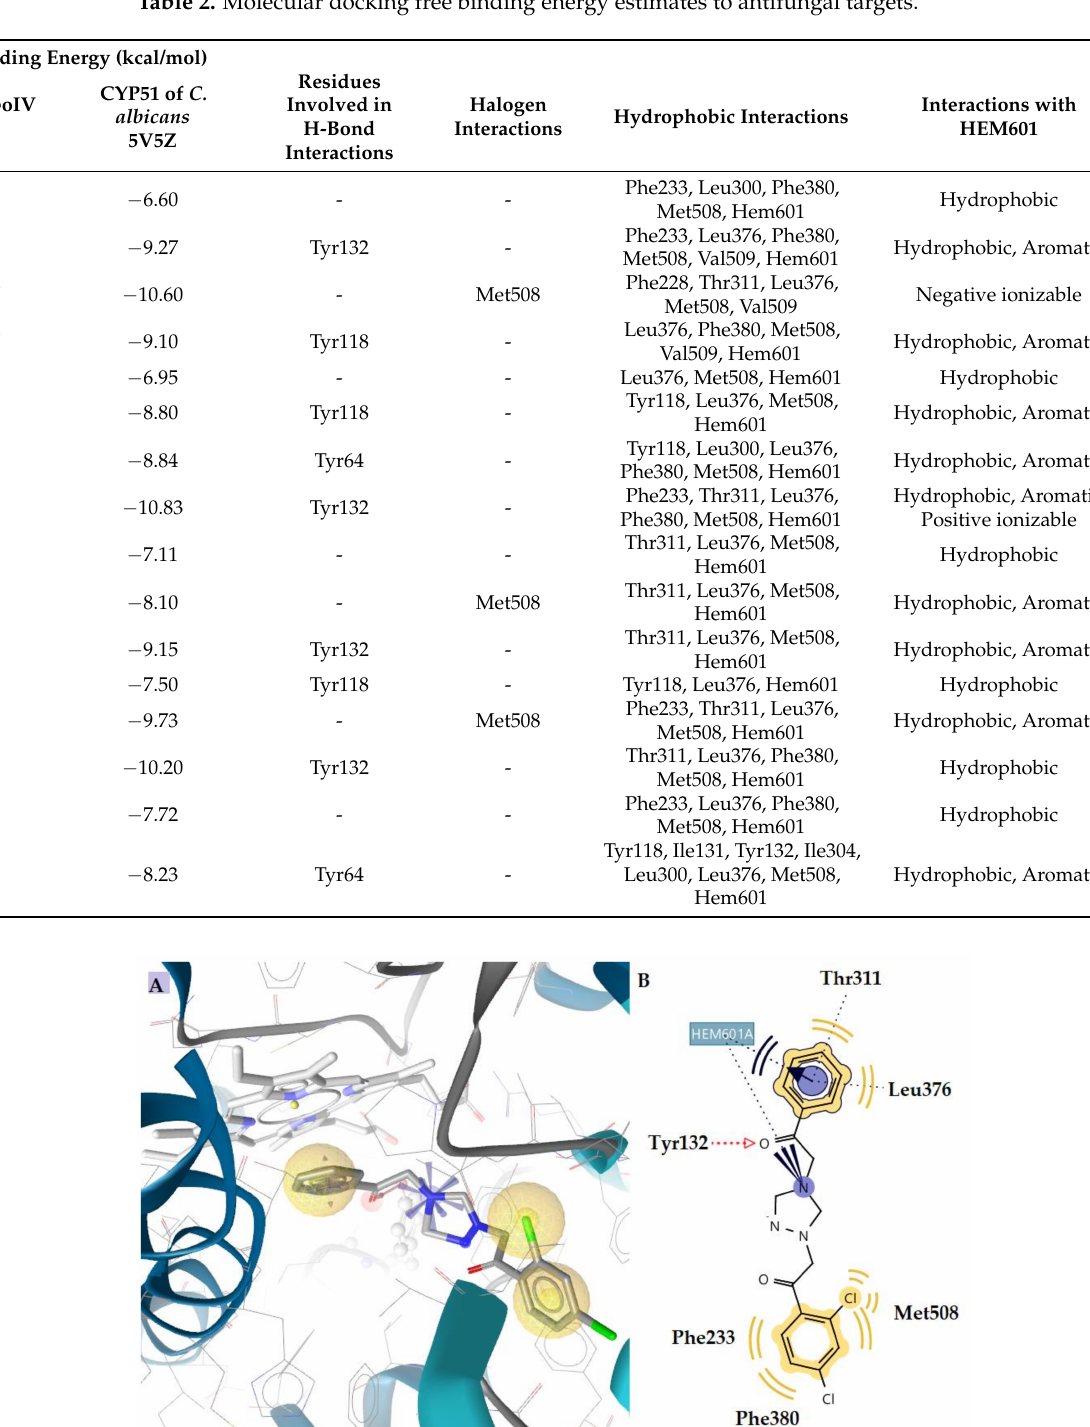
Table 2. Molecular docking free binding energy estimates to antifungal targets.